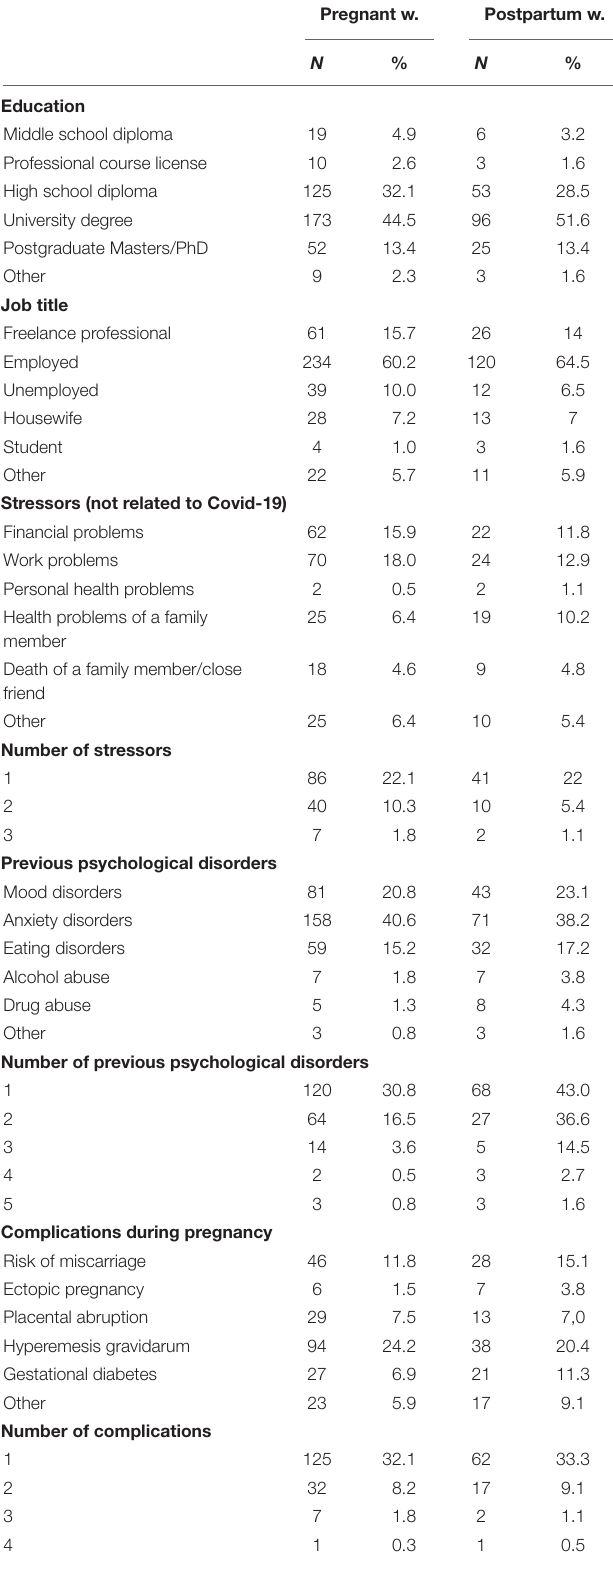
TABLE 1 | Descriptive statistics for pregnant women and postpartum women. Pregnant